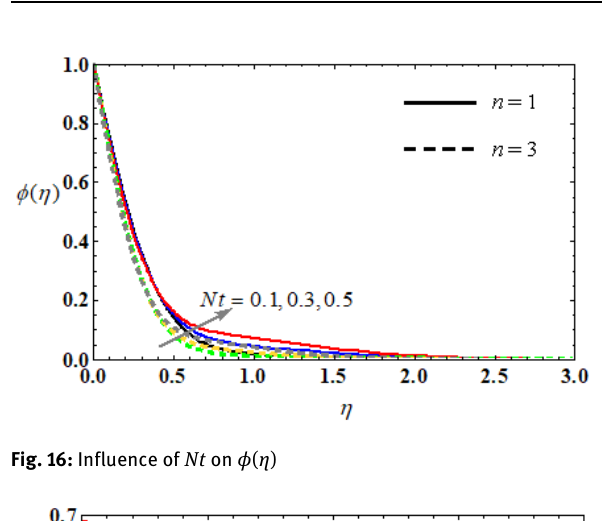
Fig. 16: Influence of Nt on ϕ ( η )